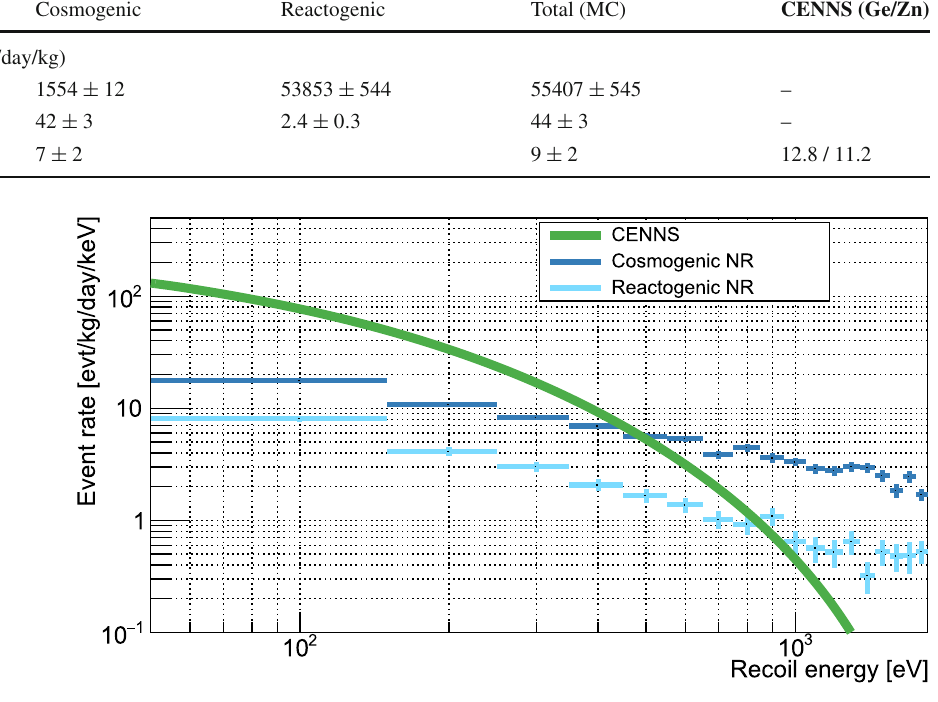
Table1 Simulatedbackgroundratesinsidethecryogenicdetectorarray installed at the ILL, with the shielding design illustrated in Fig. 1, when only one bolometer has triggered. As the muon veto is still being char-